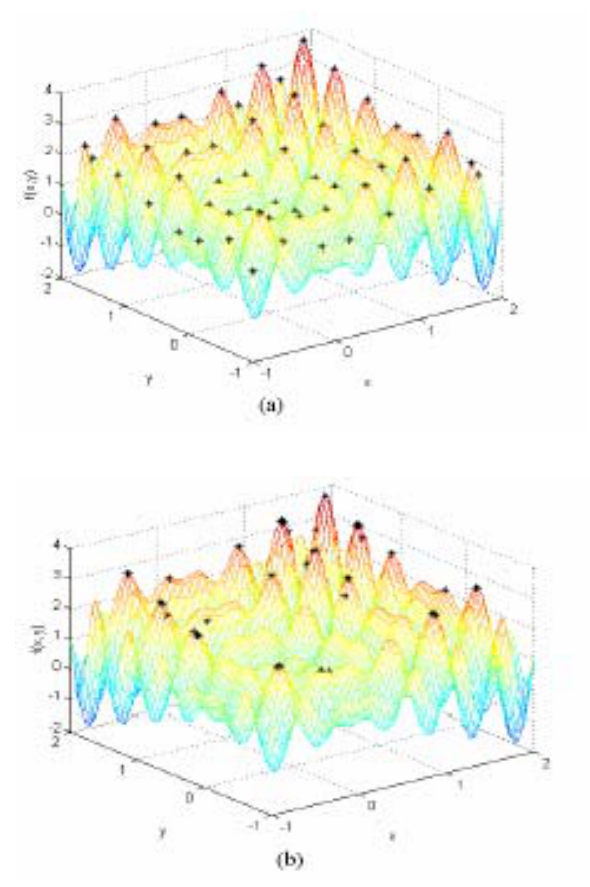
Figure 9. Multimodal function optimization (a) using opt-aiNet. (b) using